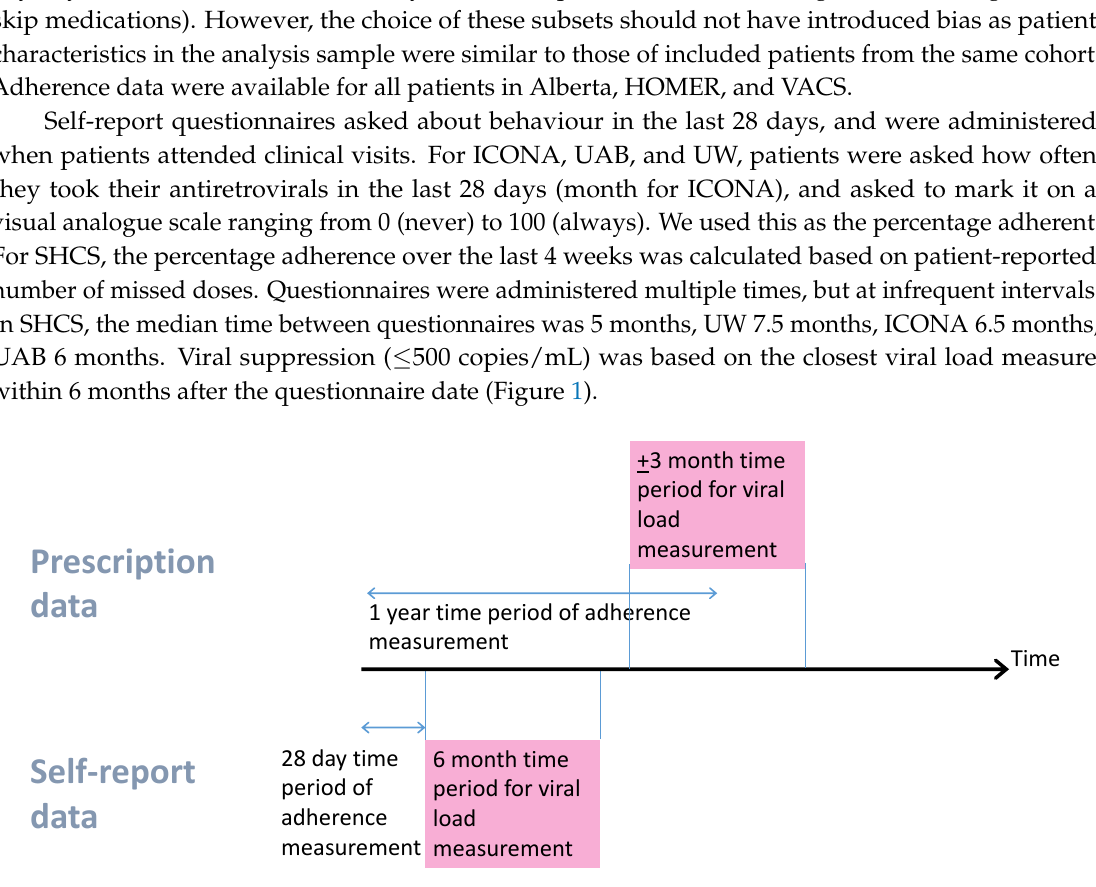
Figure 1. Data timelines. For prescription measures, there was a median of −1 day between adherence and viral load measure and, for self-report, a median of 84 days.